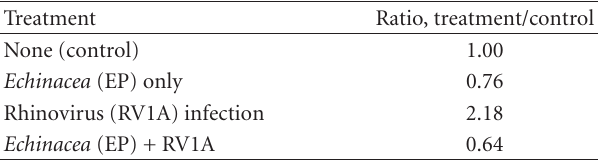
Table 4: Mucin secretion in human epithelial cell